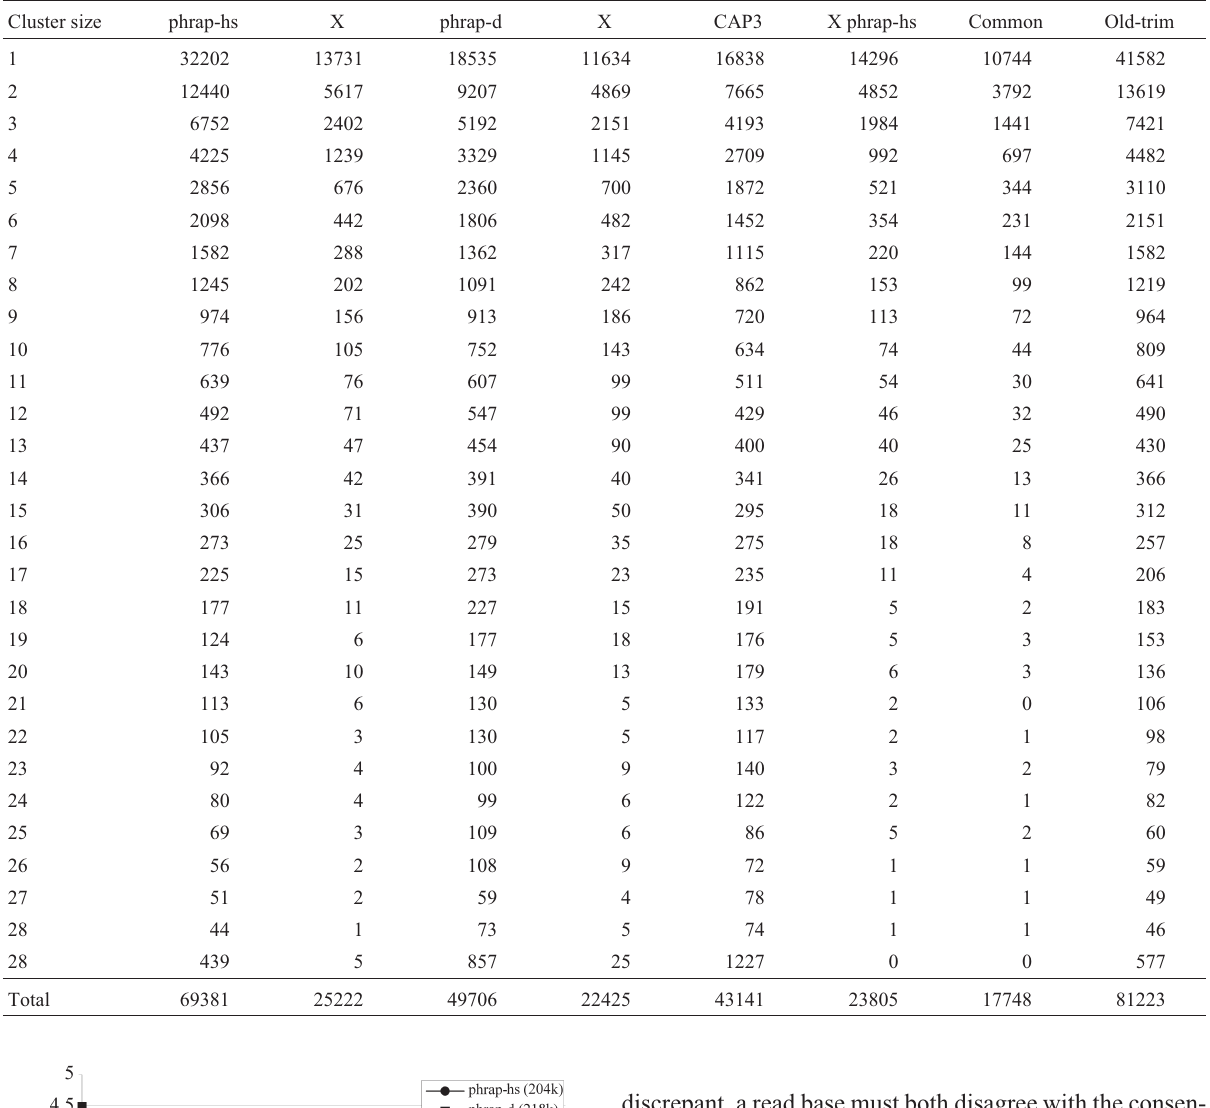
Table I - Cluster sizes distribution for CAP3, phrap-d and phrap-hs assemblies by the new trimming procedure. The ‘X’ columns indicate the number of equal clusters between two assemblies, while the ‘common’ column shows the number of clusters equal in the three assemblies. The number of clusters obtained with the original trimming procedure are shown in the ‘Old-trim’ column. Cluster sizes represent the number of expressed sequence tags (ESTs) in a cluster. Cluster size